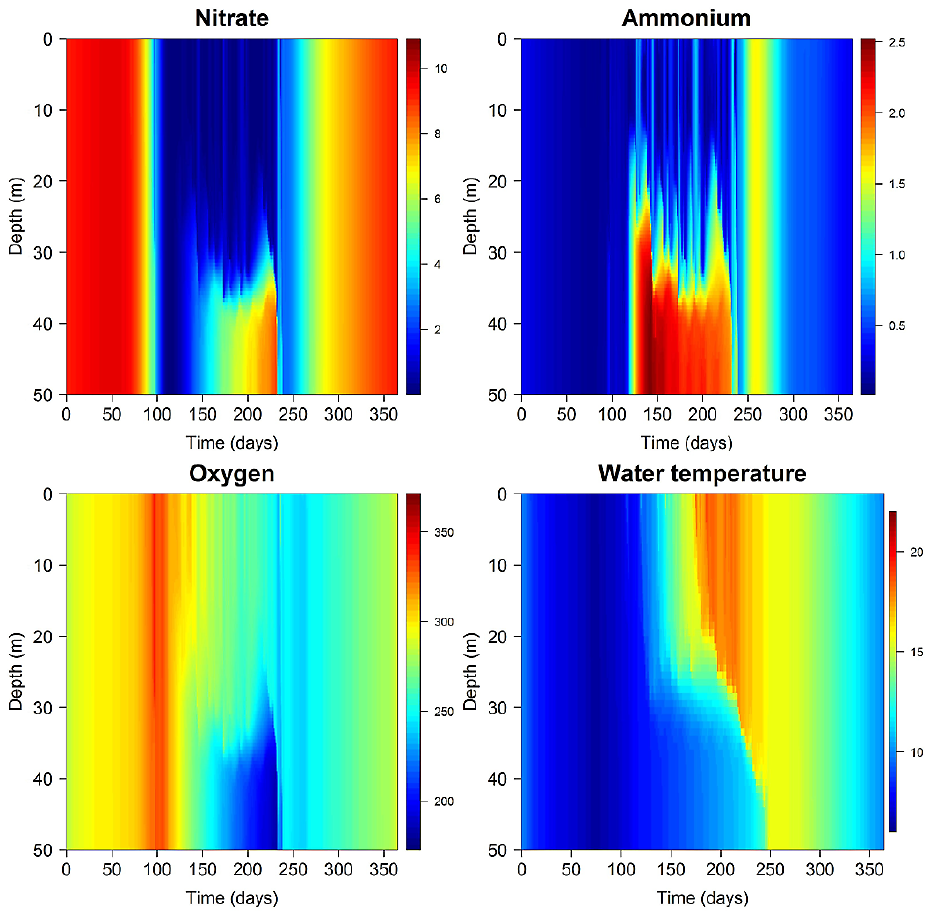
Fig. 6. Spatio-temporal plots of the nitrate, ammonium, oxygen concentrations (in mmolm − 3 ) and temperature ( ◦ C) for the year 2007.